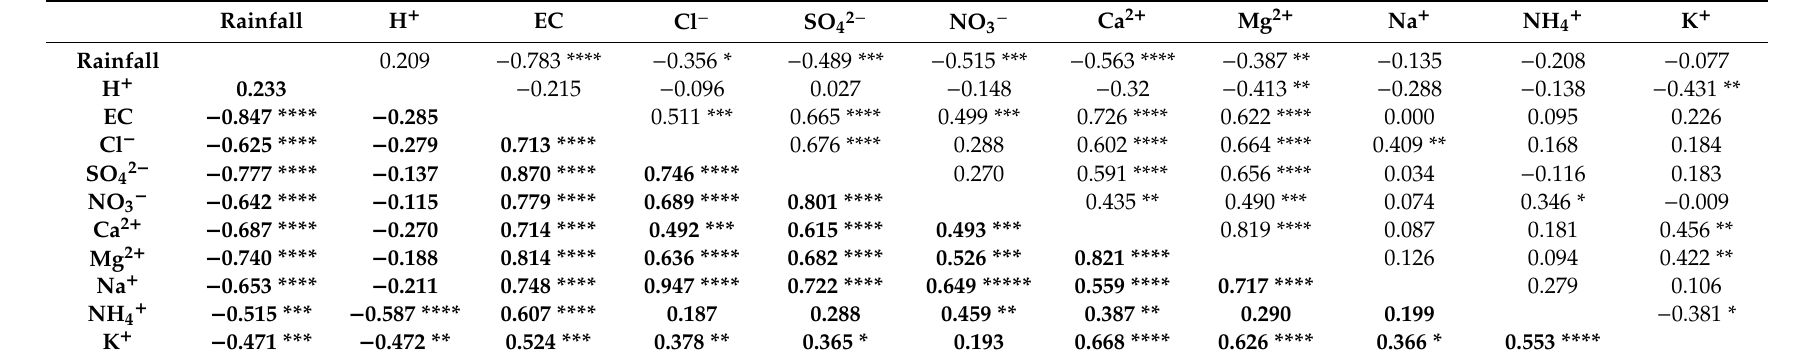
Table 4. Ion pair correlations in throughfall (regular represents Malik, bold represents